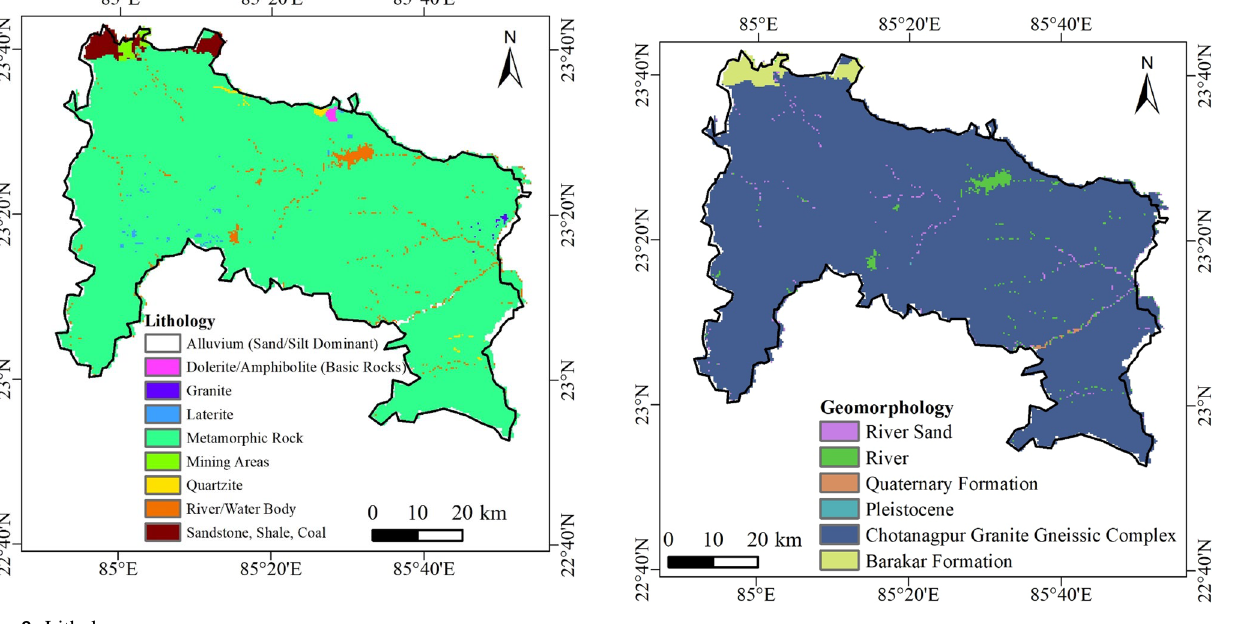
Fig. 9 Geomorphology map